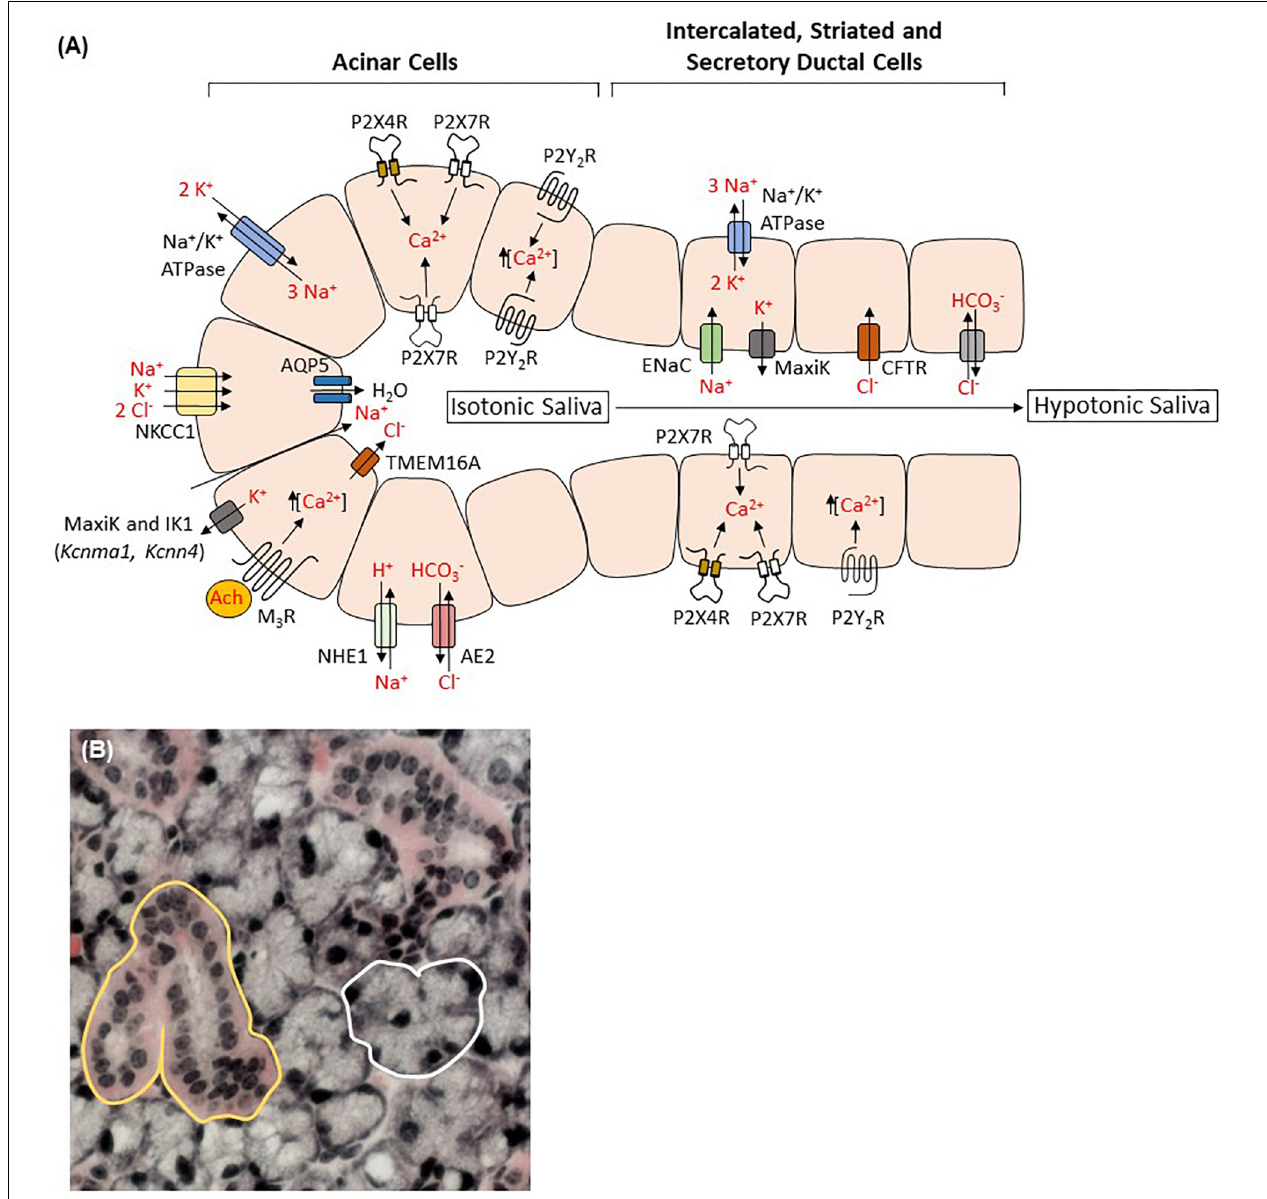
FIGURE 1 | Salivary gland acinar and ductal cells contribute to saliva formation. (A) Activation of type 3 muscarinic receptors (M 3 R) by acetylcholine (Ach) increases release of calcium from intracellular stores and subsequent opening of the apical Ca 2 + -dependent chloride channel transmembrane member 16A (TMEM16A; also known as anoctamin-1) and the basolateral Ca 2 + -dependent potassium channels MaxiK ( Kcnma1 ) and IK1 ( Kcnn4 ), allowing Cl − efflux into the luminal compartment and K + efflux into the basolateral compartment to maintain membrane potential. The combined actions of the Na + /K + /2 Cl − cotransporter NKCC1, the Na + /H + exchanger NHE1 and the Cl − /HCO − 3 anion exchanger AE2 maintain the pool of intracellular Cl − whereas the Na + /K + ATPase generates the cellular Na + and K + gradients. Sodium influx down the negative electrochemical gradient into the luminal compartment is followed by water through aquaporin 5 (AQP5) water channels generating primary isotonic saliva. Modification of saliva by ductal cells involves exchanging sodium and chloride for potassium and bicarbonate through the combined actions of epithelial Na + channels (ENaC), cystic fibrosis transmembrane conductance regulator (CFTR) channels, MaxiK channels and perhaps Cl − /HCO − 3 exchangers. The resulting hypotonic saliva is then secreted through ducts into the oral cavity. Functional P2X4, P2X7, P2Y 1 , and P2Y 2 receptor expression has been demonstrated in both acinar and ductal cells where they may regulate secretory functions through nucleotide-induced Ca 2 + signaling and modulation of membrane ion conductance. Available evidence suggests that P2X7 and P2Y 2 receptors exist on both apical and basolateral membranes while P2X4 receptors are restricted to the basolateral compartment and P2Y 1 receptor localization is undetermined. Importantly, P2 receptor expression in salivary gland tissue varies depending on species, isolation/culture methods and the presence of inflammatory stimuli, making definitive localization inexact. (B) Acinar (white) and ductal (yellow) cells outlined in a hematoxylin and eosin-stained section of a female C57BL/6 mouse submandibular gland.